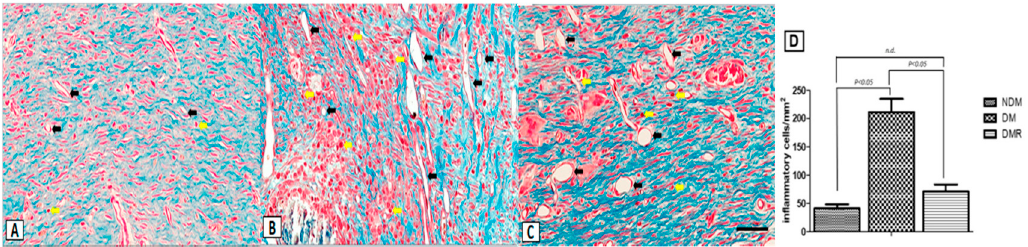
Figure 5. Masson’s trichrome staining of NDM ( A ), DM ( B ), and DMR ( C ) wound sections on day 21. There were significant strain-specific differences in collagen fibril deposition. The yellow arrow denotes inflammatory cells, while the black arrow denotes blood vessel. Quantitative analysis of inflammatory cells was performed using Image J analysis software ( D ). Scale bar: 50 μ m.